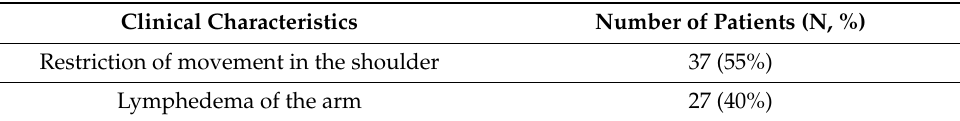
Table 2. Clinical characteristics in breast cancer survivors.